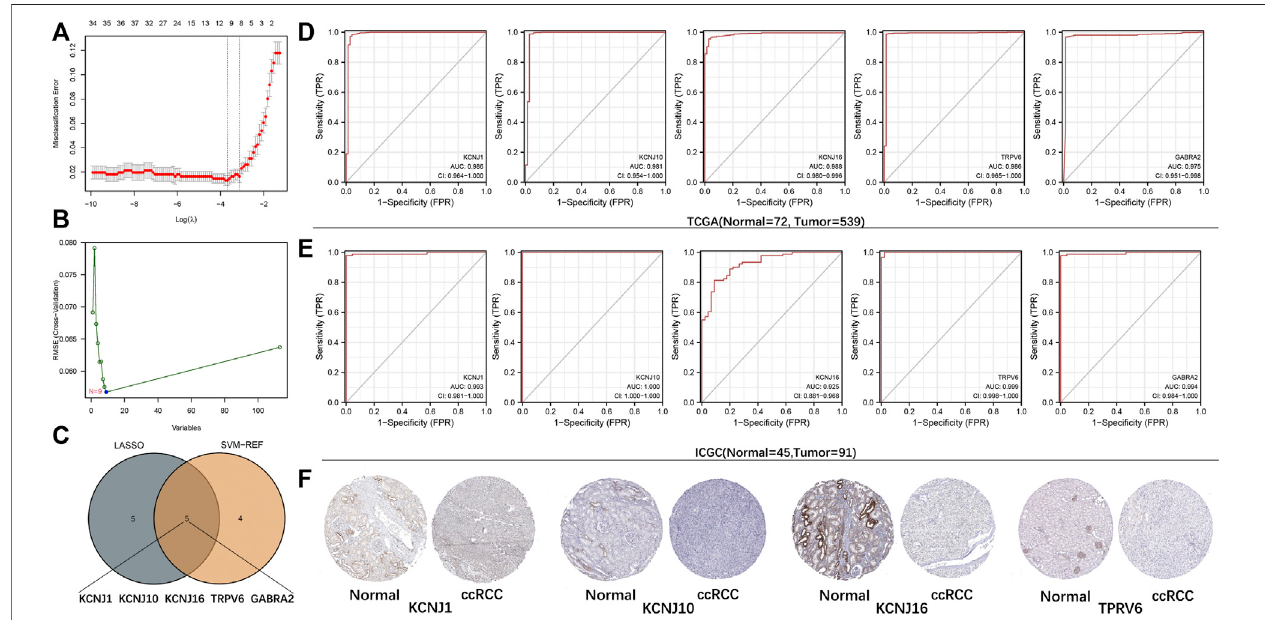
FIGURE 3 | Establishment and validation of the diagnostic signature based on ICRGs. (A) LASSO regression to identify signature genes in ccRCC and normal samples. (B) SVM-REF approach to identify signature genes in ccRCC and normal samples. (C) Venn diagram based on the intersection of the two algorithms with fi ve genes. (D) ROC curves of fi ve signature genes for predicting the diagnostic value in TCGA cohort. (E) ROC curves of fi ve signature genes for predicting the diagnostic value in the ICGC cohort. (F) Expression trends of four signature genes (except for GABRA2) were observed in protein expression data based on the HPA